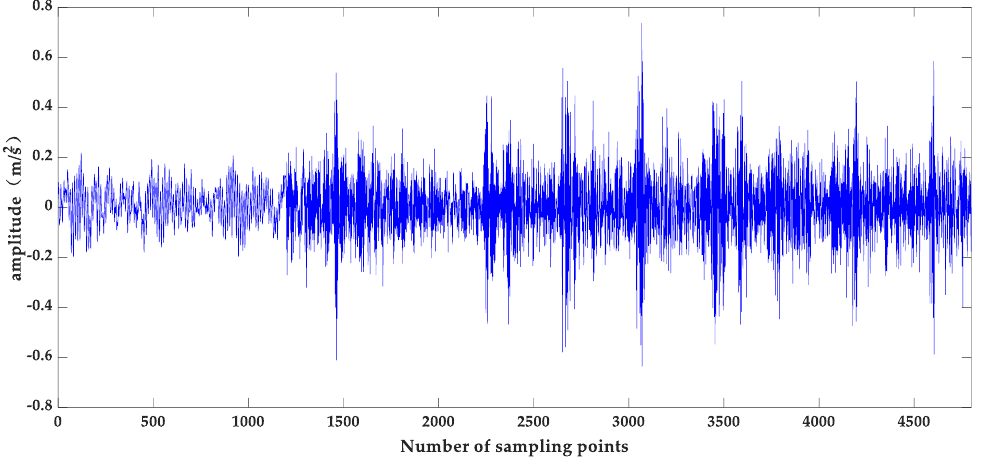
Figure 3. The signal of bearing fault.